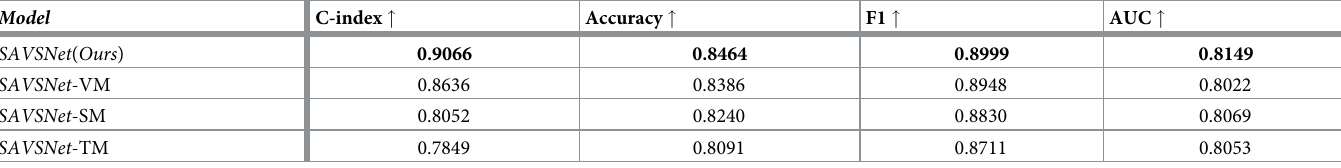
Table 4. Ablation study of key components of SAVSNet.